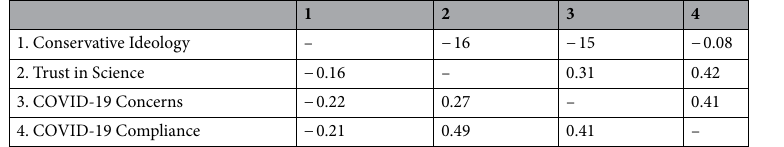
Table 1. Bivariate correlations for Study 2a (below the diagonal) and Study 2b (above the diagonal). All coefficients are higher than .10 are significant at p < 0.001, all coefficients below .10 are significant at p < .01.